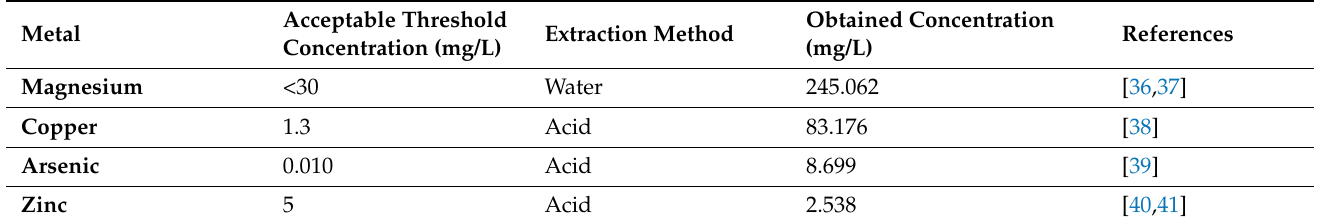
Figure 9. Concentrations of heavy metals obtained by acid and water extraction of microplastics filtered from influent samples using PVDF membranes. Table 5. Comparison between the concentrations of heavy metals extracted from microplastics filtered from influent samples using PVDF membranes and the acceptable limits in drinking water.